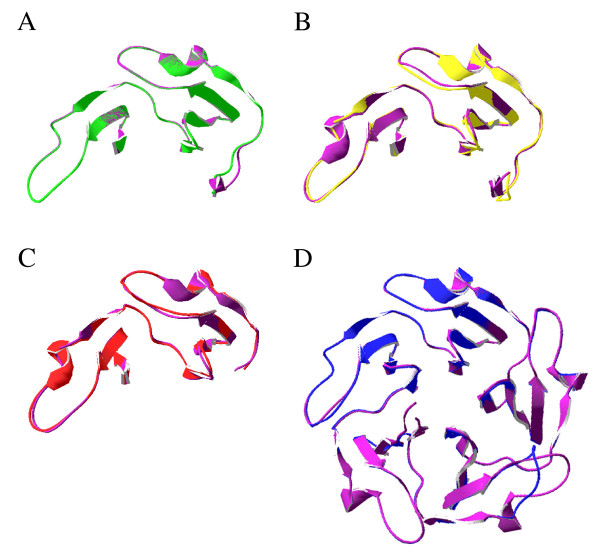
Ribbon diagrams of tachylectin-2s from Oculina (A), Acropora (B), Montastrea (C) and Nematostella (D). Each structural model has been superimposed on the known structure of 1tl2 (purple), with the Oculina structure represented in green, Acropora in yellow, Montastrea in red and Nematostella in blue.